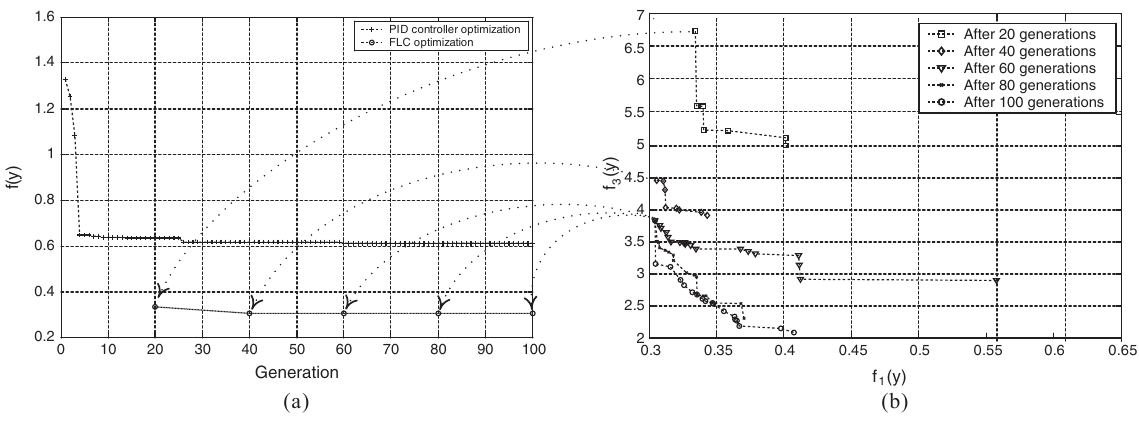
Fig. 12. (a) Convergence of objective functions with generation for both PID and FL controller optimization, (b) Non-dominated solution fronts for MOGA optimization of